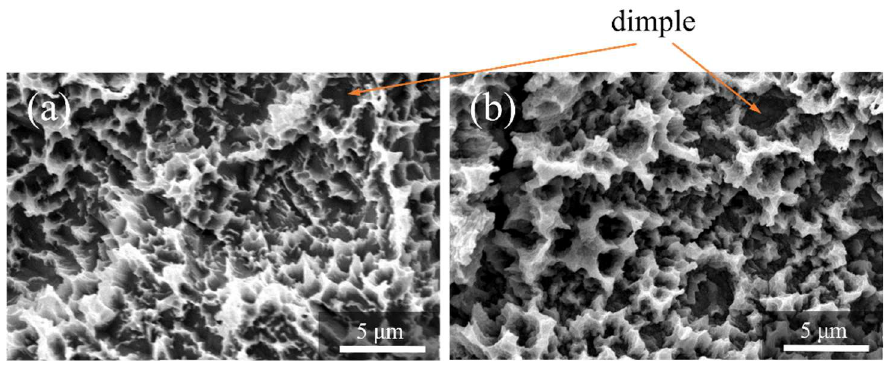
Figure 4. SEM profiles of the surfaces of the ( a ) Ti and ( b ) ZrO 2 /Ti disks.